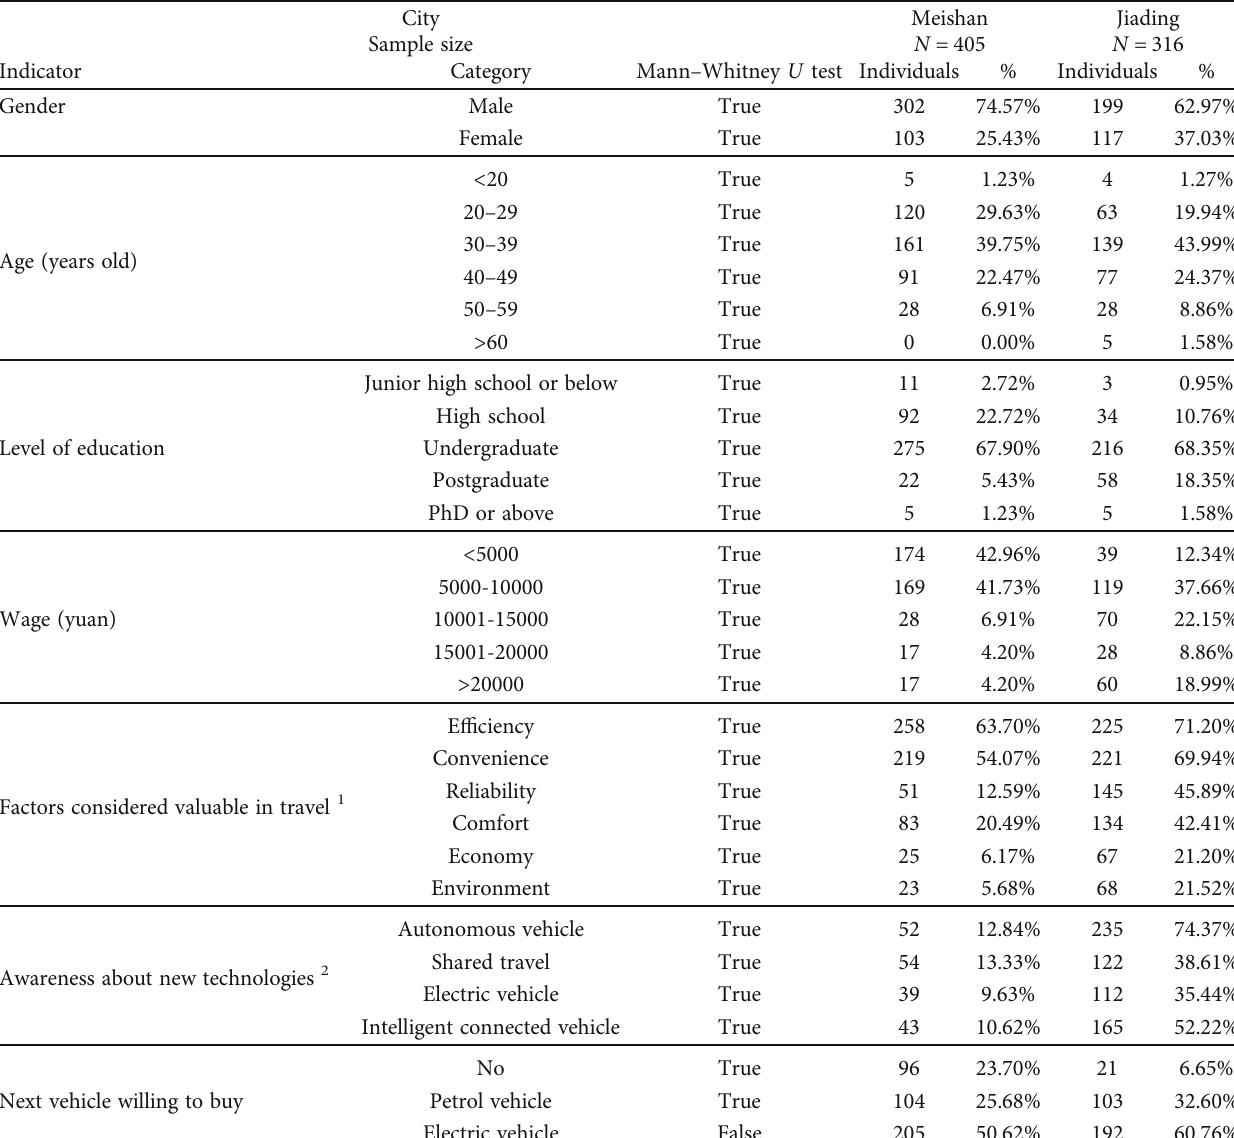
Table 4: Personal characteristics of the sample in the two cities.